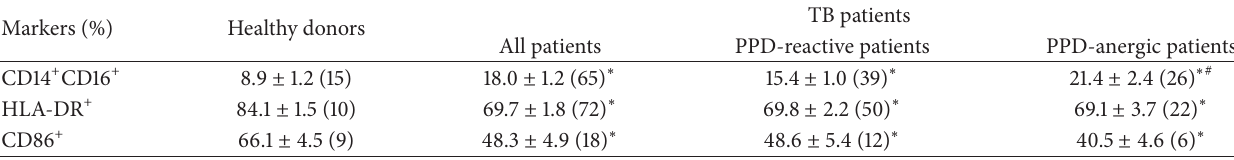
Table 1: The phenotypic characteristics of monocytes obtained from peripheral blood of healthy donors and TB patients. Markers (%)